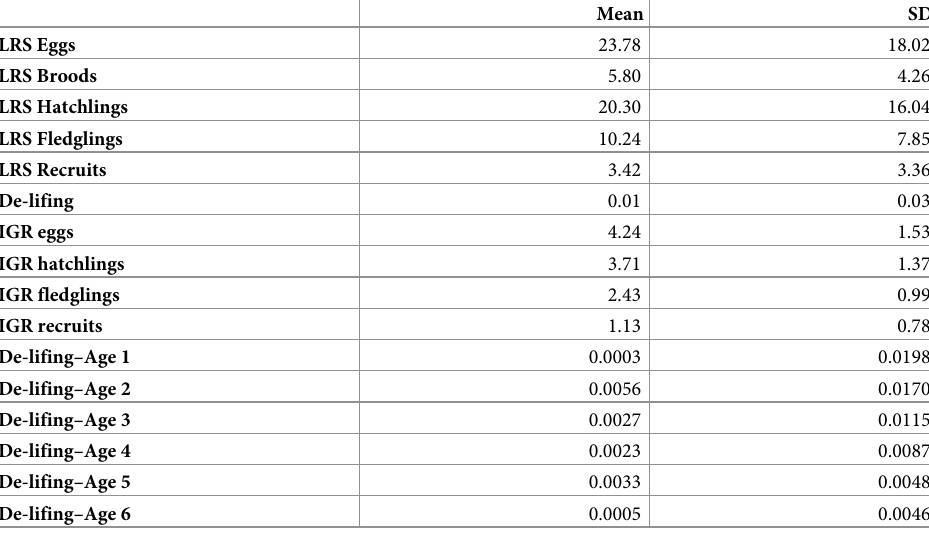
Table 1. Mean and standard deviation for short-term fitness proxies at different offspring stages, and de-lifed fit- ness at different ages.